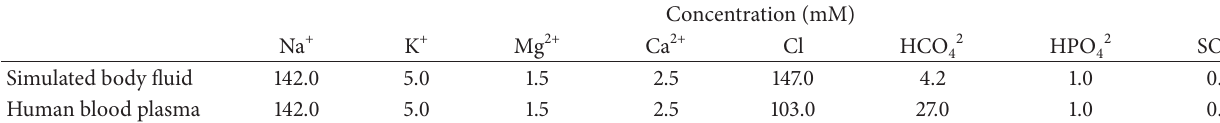
Table 1: Ion concentrations of simulated body fluid and human blood plasma [17].